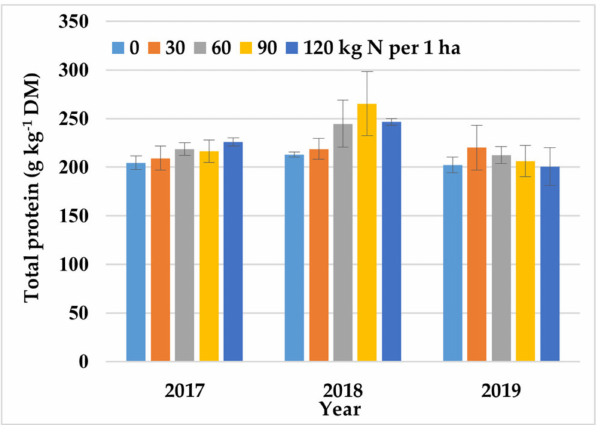
Figure 6. The e ff ect of N fertilization on the total protein content of crambe seeds across growing seasons (2017–2017). Error bars represent the standard